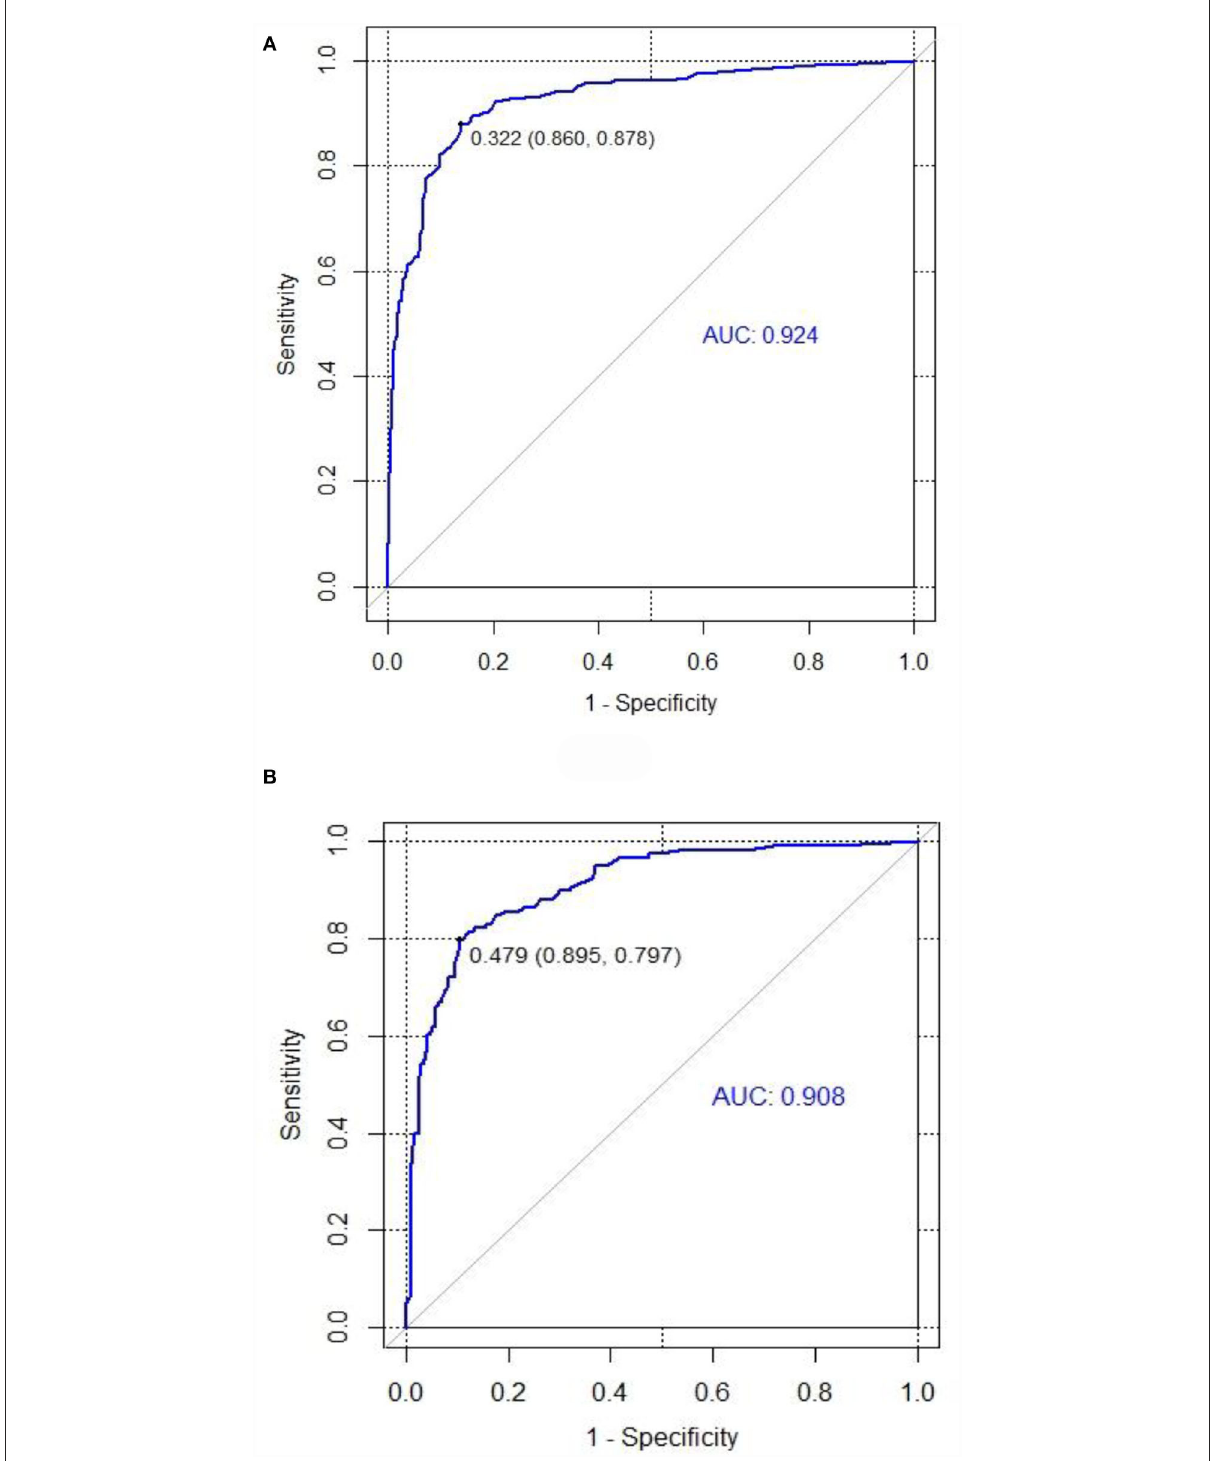
FIGURE4 ROC curves for training and validation sets in the nomogram prediction model. (A) Training set. (B) Validation set (AUC = 0.92, AUC = 0.91). The area under the ROC curve was 0.92 and 0.91 in the training set and the validation set,